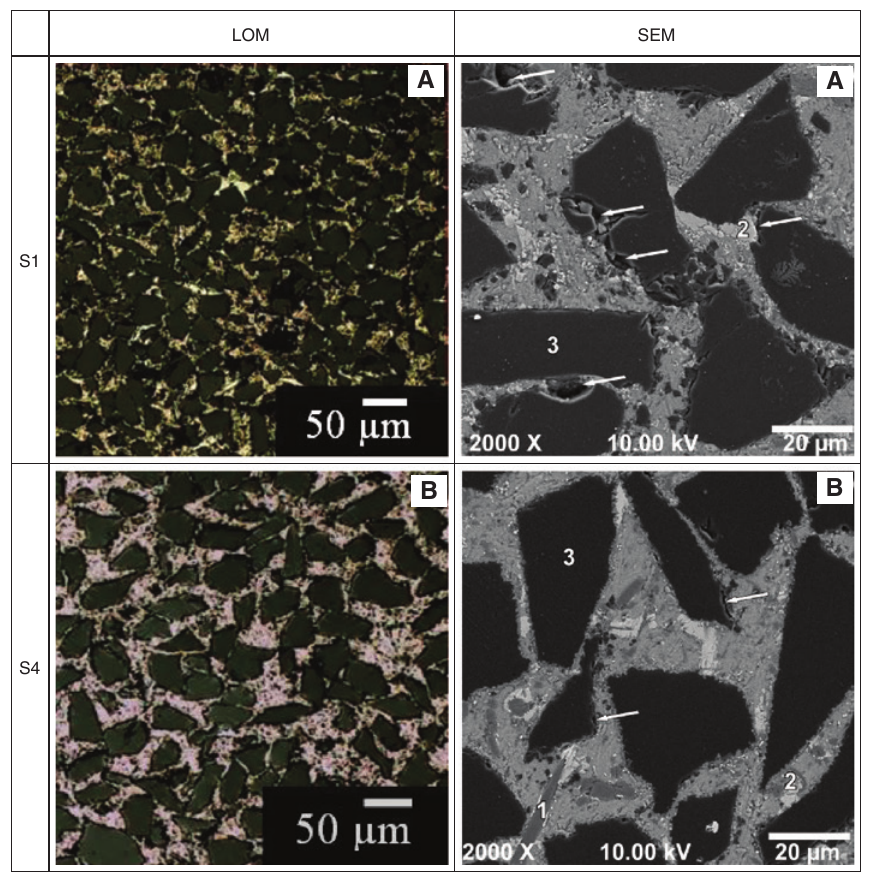
Figure 1: Microstructure of (A) S1 and (B) S4 composites. The arrows show some of the porosities present in the compacts.